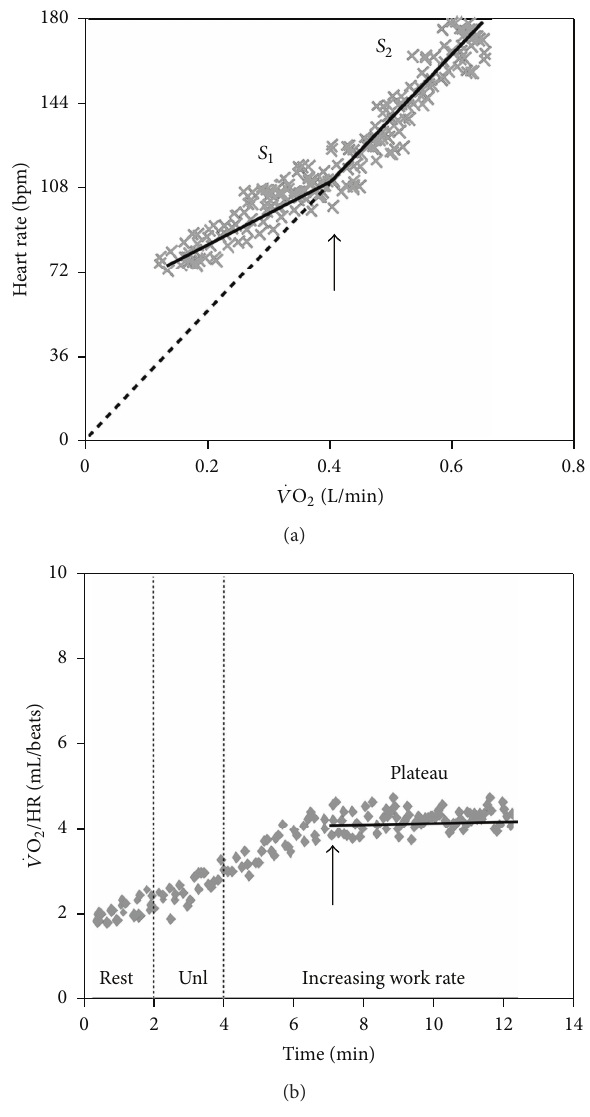
̇𝑉 ) O 2 ̇𝑉 / HR ratio) as the 𝑦 -intercept O 2